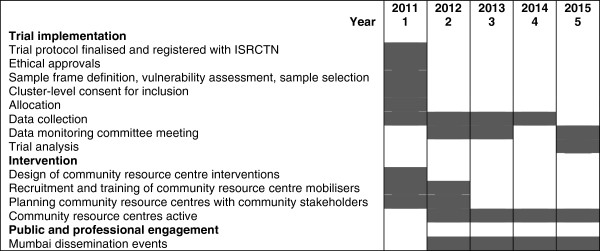
Program timeline.